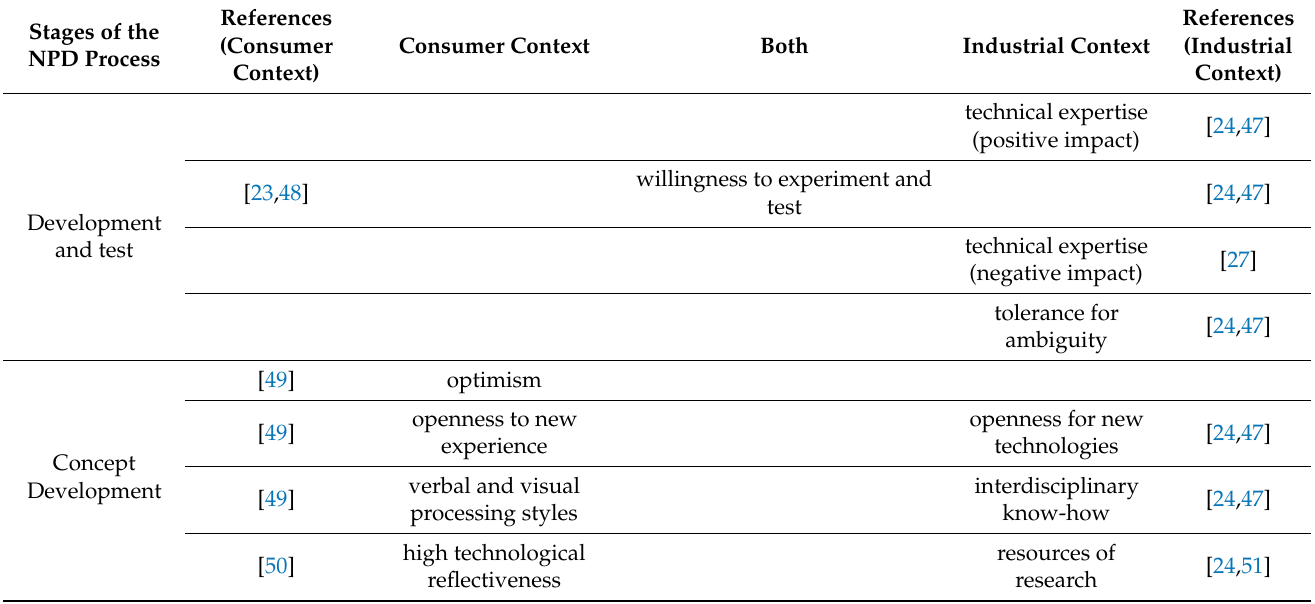
Table 7. Lead user personal characteristics in consumer and industrial